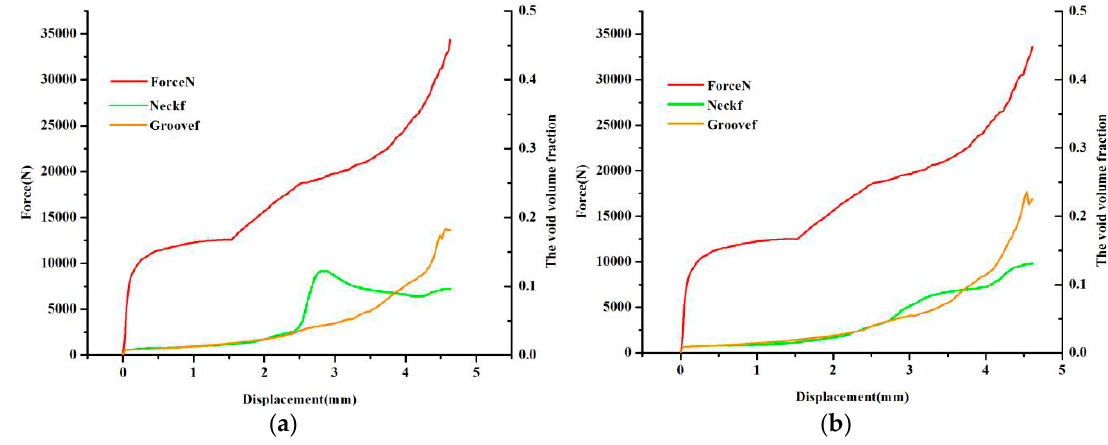
Figure 8. The subject parameters changing. ( a ) The original damage parameter; and ( b ) the optimized damage parameter. Table 7. The final optimized parameters for